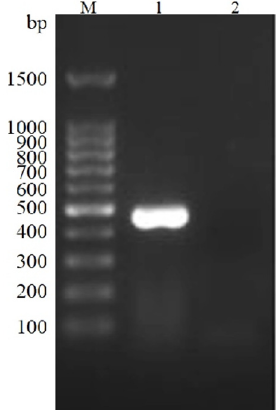
Figure 1. Detection of PCV2 ORF2 by PCR. M: DNA Ladder; 1: Lungs; 2: Negative control.